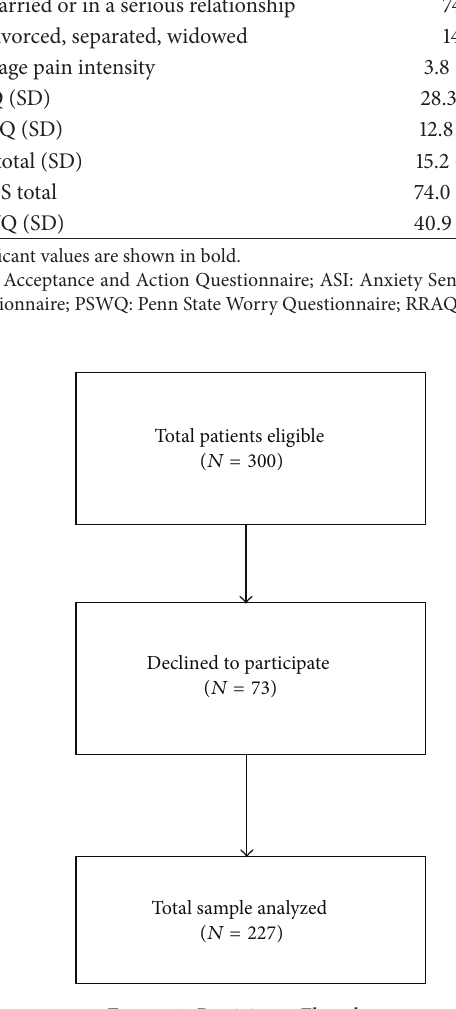
Figure 1: Participant